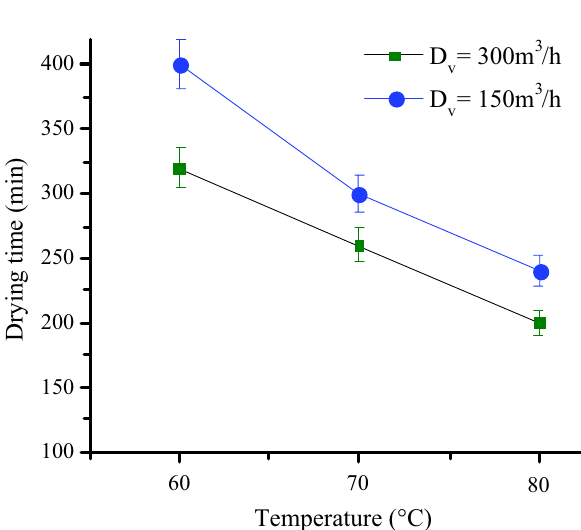
Figure 3. Drying time as a function of temperatures and drying volume flow